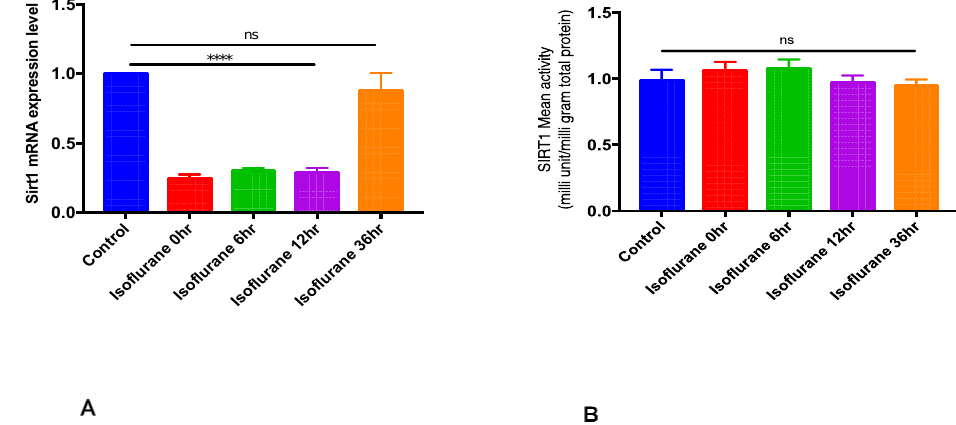
Figure 1. Isoflurane and SIRT1 mRNA expression and activity. Wild-type mice were exposed to air or 2% isoflurane for 1 h and cortical tissue was harvested immediately and at 6, 12, and 36 h after isoflurane exposure were subjected to RT-PCR and ELISA. Data indicate mean ± SEM. ( A ) **** p < 0.0001 vs. control (no isoflurane) by ANOVA, ns—nonsignificant. ( B ) ns—nonsignificant, p > 0.05 vs. control (no isoflurane) by ANOVA. ( n = 5).